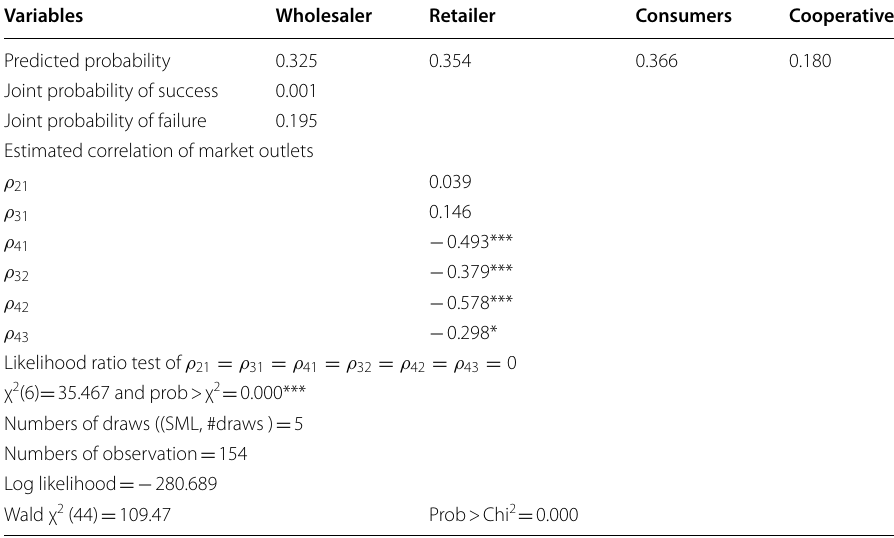
*** and * are statistically significant at 1% and 10% significance level,